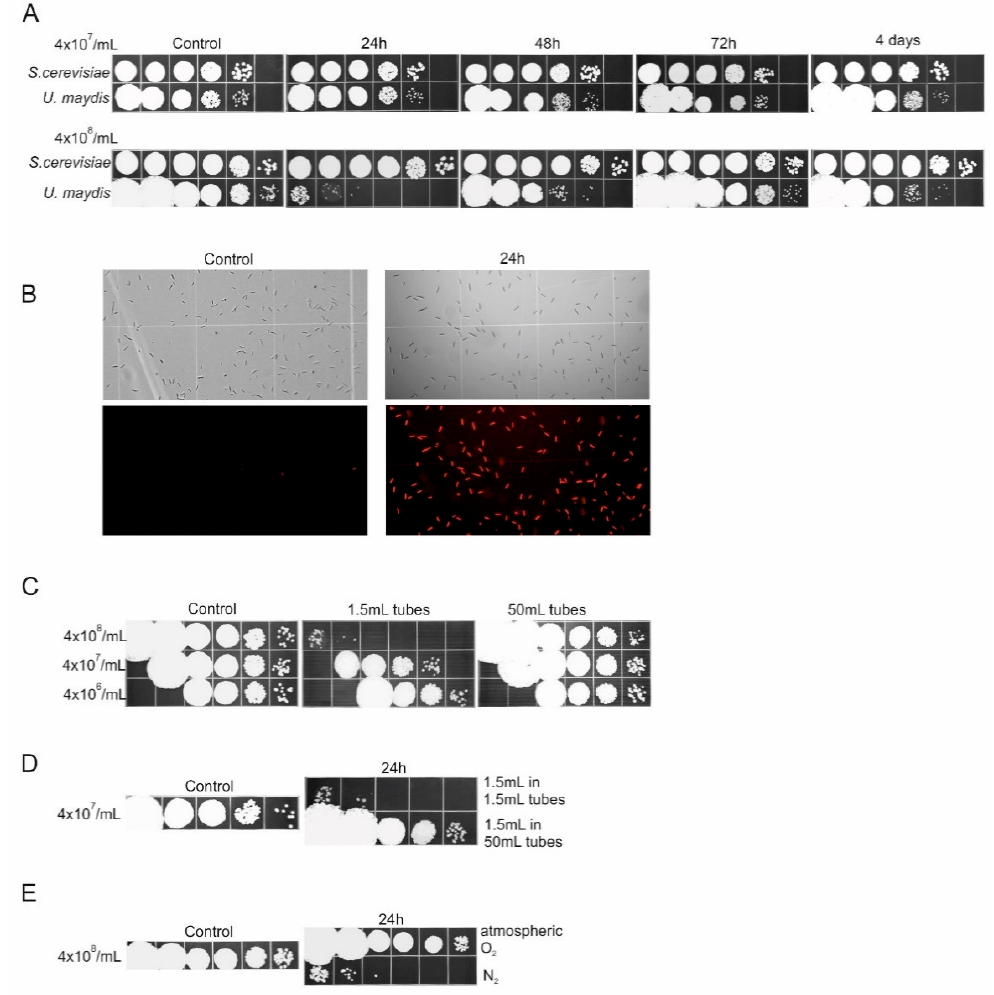
Figure 1. Viability of S. cerevisiae and U. maydis cells upon water transfer. ( A ) One milliliter of cell suspensions of 4 × 10 7 cells/mL (upper panels) and 4 × 10 8 cells/mL (lower panels) were incubated in water in 1.5 mL tubes for 4 days. Aliquots were withdrawn at one day intervals, used for preparation of 10-fold serial dilutions, and spotted on the solid rich medium. ( B ) Brightfield and fluorescent imaging of cells stained with propidium iodide (PI). Water-transferred early-stationary phase cells (4 × 10 8 cells/mL) were stained with PI before (Control, left micrographs) and after 24 h of incubation (right micrographs) for detection of damaged/dead cells. Fluorescence micrograph of 24-h-incubated cells clearly showed that nearly all cells were fluorescing red, indicating membrane damage. ( C ) One milliliter of U. maydis cell suspensions (4 × 10 8 /mL, 4 × 10 7 /mL, and 4 × 10 6 /mL) were incubated in water in 1.5 mL tubes and 50 mL tubes for 24 h. Ten-fold serial dilutions were spotted on the solid growth medium. ( D ) One-and-a-half milliliter of U. maydis cell suspensions (4 × 10 7 /mL) were incubated in water for 24 h in 1.5 mL tubes and 50 mL tubes; 10-fold serial dilutions were spotted on the solid growth medium. ( E ) One milliliter of 4 × 10 8 U. maydis cell suspensions were incubated in water in 50 mL tubes for 24 h, under atmospheric air (O 2 ) or under N 2 atmosphere. Ten-fold serial dilutions were spotted on the solid growth medium. Left panels represent the starting number of cells in suspensions (Control). All experiments were performed at least three times and the representative results are shown.